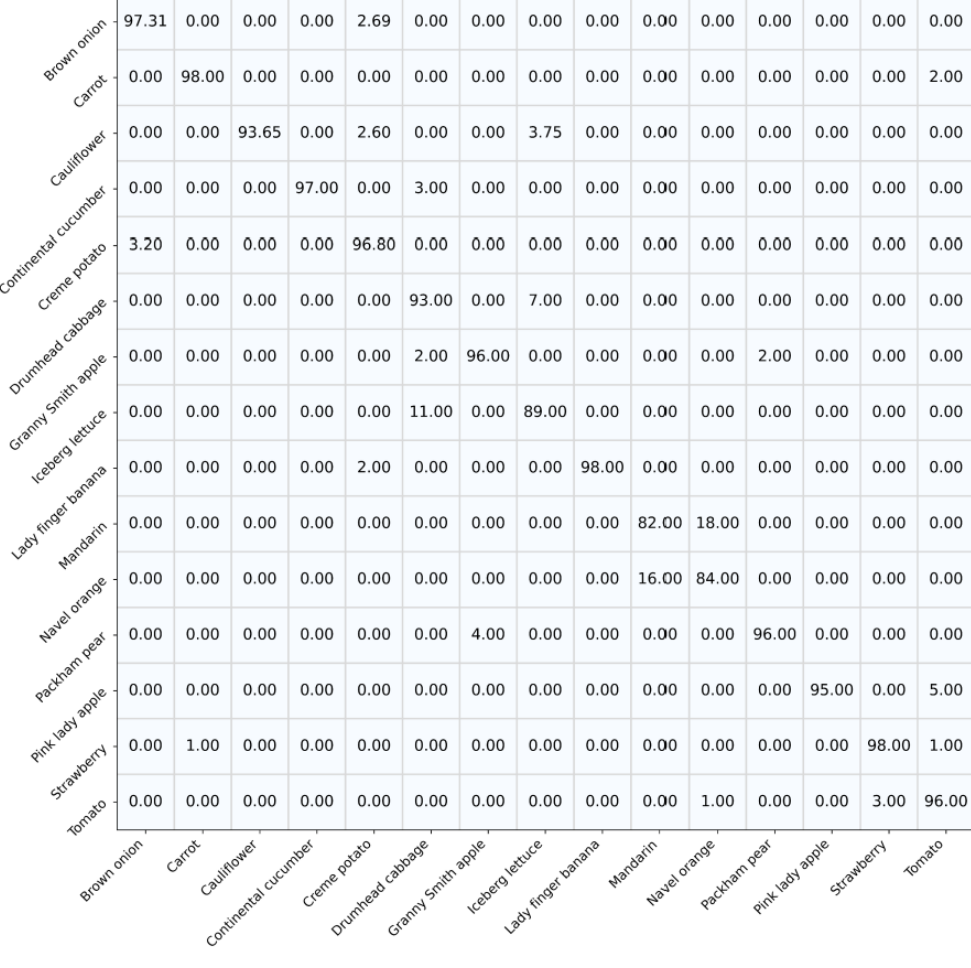
Figure 5. A classification confusion matrix of fruit and vegetables for the custom CNN. Table 9. Hardware description for inference time analysis.